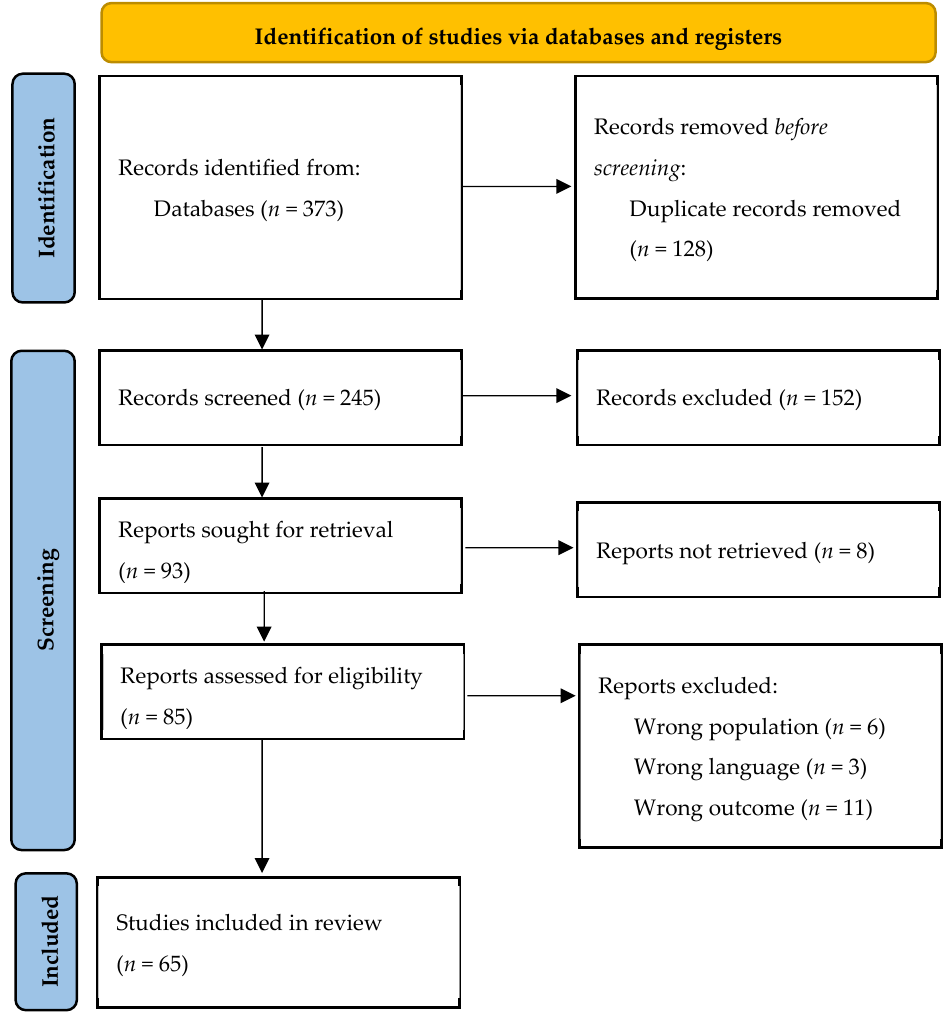
Figure 1. PRISMA flow chart.